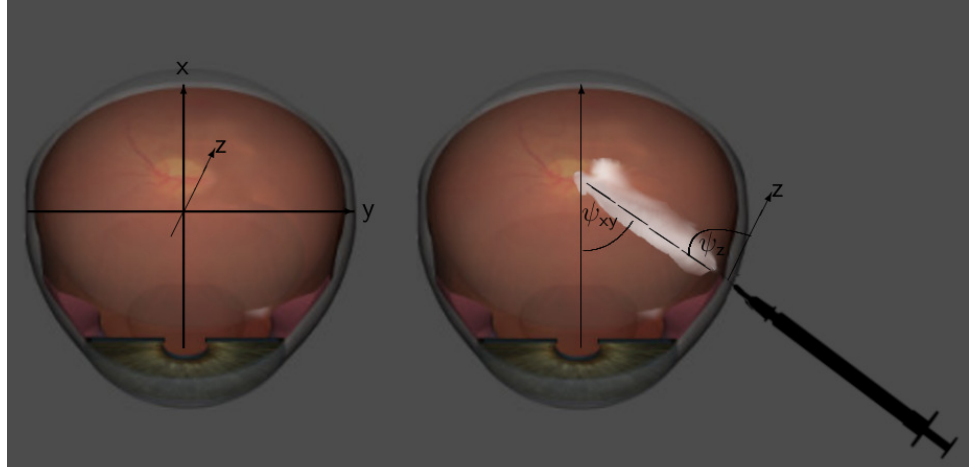
Figure 6. On the left, our coordinate system in our Virtual Eye, and on the right, a schematic representation of the two penetration angles ψ xy and ψ z of the injection for orientation in space.